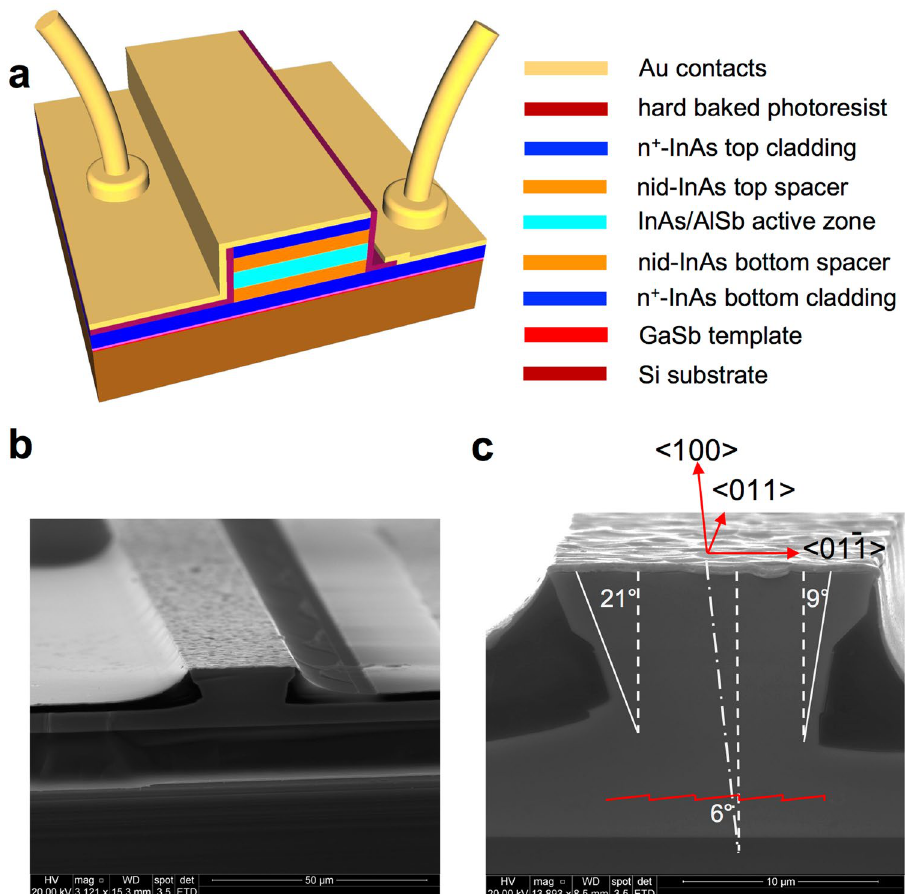
Figure 2. Schematic and SEM photographs of the fabricated lasers. ( a ) Schematic of ridge lasers fabricated on the Si substrate. Different materials and layers are denoted in the order of their appearance in the structure by the color code shown in the right. ( b ) SEM image of the fully processed wafer. Contact pads correspond to the scheme presented in Fig. 1a. ( c ) SEM image of the cleaved facet of the laser demonstrating an asymmetric shape of the ridge formed by anisotropic wet etching of the misoriented structure. Crystallographic directions and a schematic of atomic plane steps induced by the miscut of the substrate are also